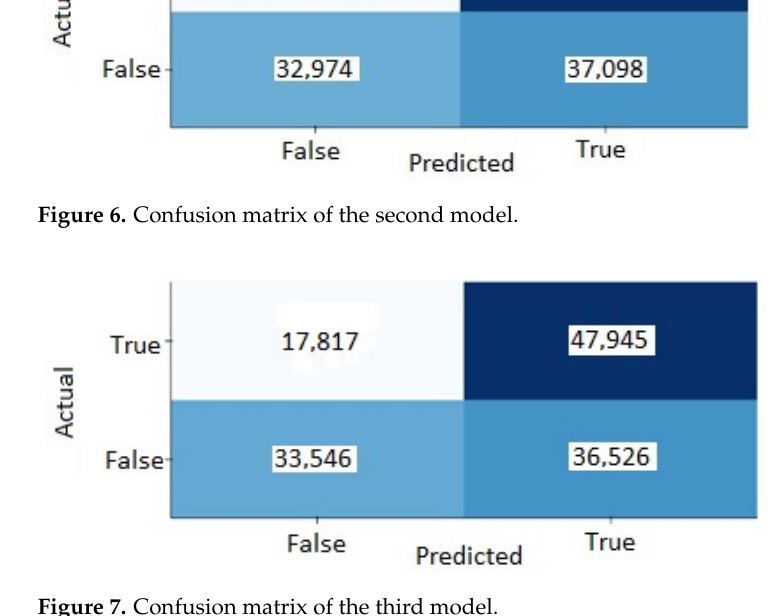
Figure 8. Confusion matrix of the fourth model.